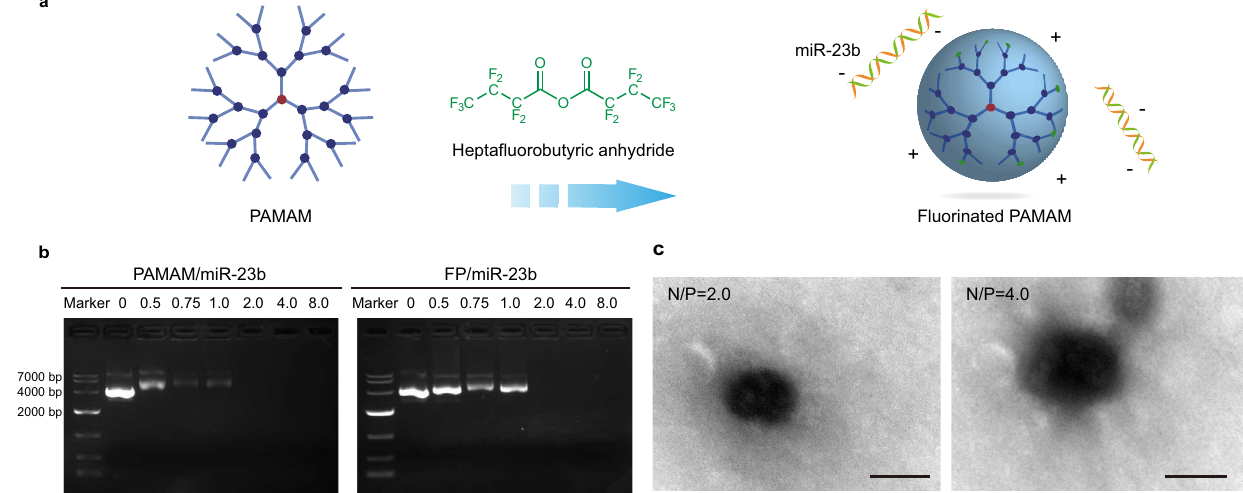
Fig. 1 | Synthesis and characterization of fl uorinated PAMAM (FP). a The illus- trationrepresentsthe fl uorinationofPAMAMdendrimerthroughthemodi fi cation withhepta fl uorobutyricanhydrideandtheformationofFP/miR-23bnanoparticles. b ThebindingandcondensationabilityofPAMAMandFPwithmiR-23batdifferent